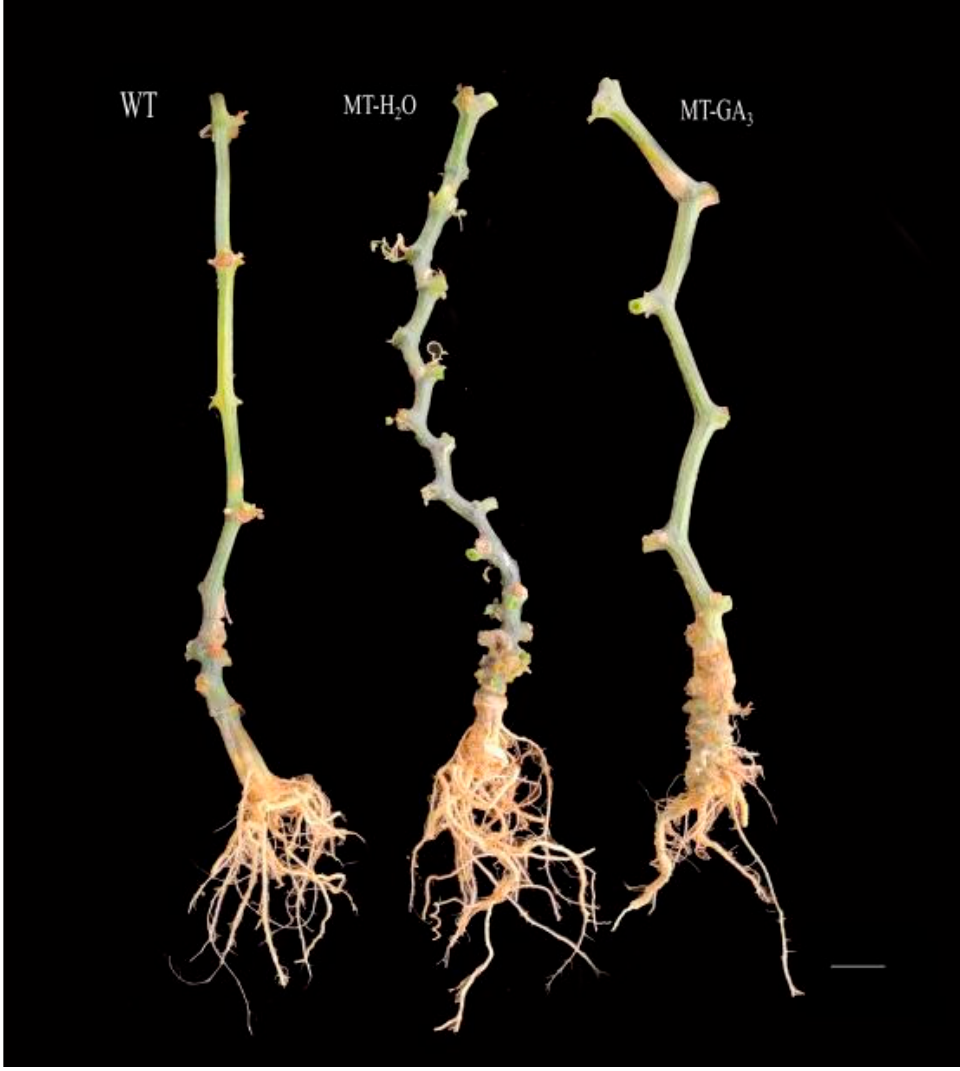
Figure 7. Recovery of the dwarf mutant by treatment with exogenous GA 3 . WT, mutant Si1 treated with 100 μ M GA 3 , and mutant Si1 treated with H 2 O are shown. Bar, 2 cm.